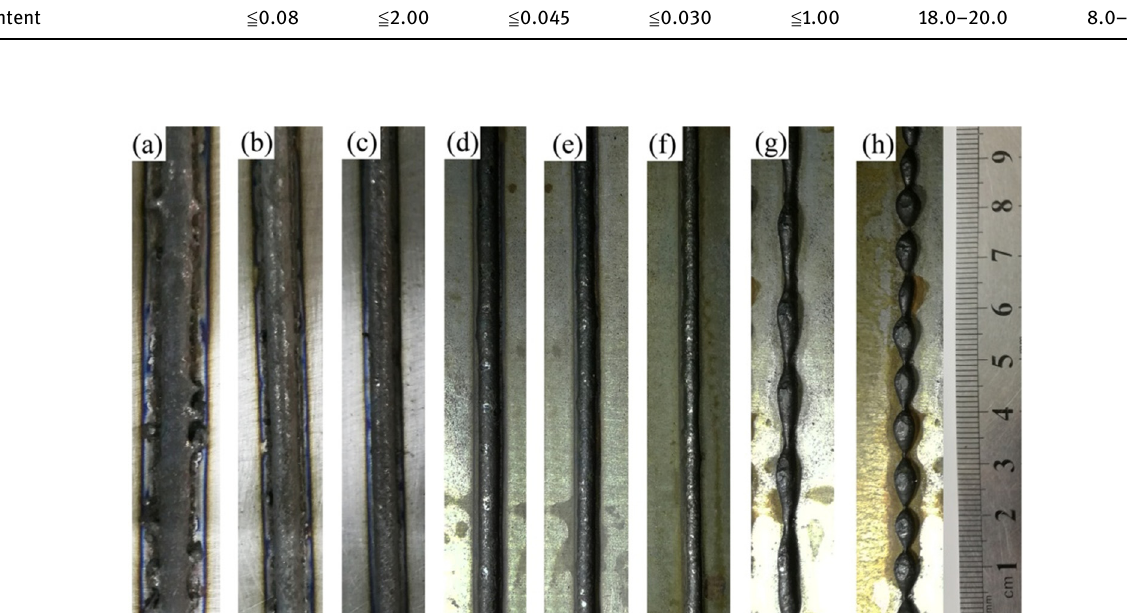
Table 1: Chemical composition of 304 stainless steel powder ( mass fraction ( % )) Chemical composition